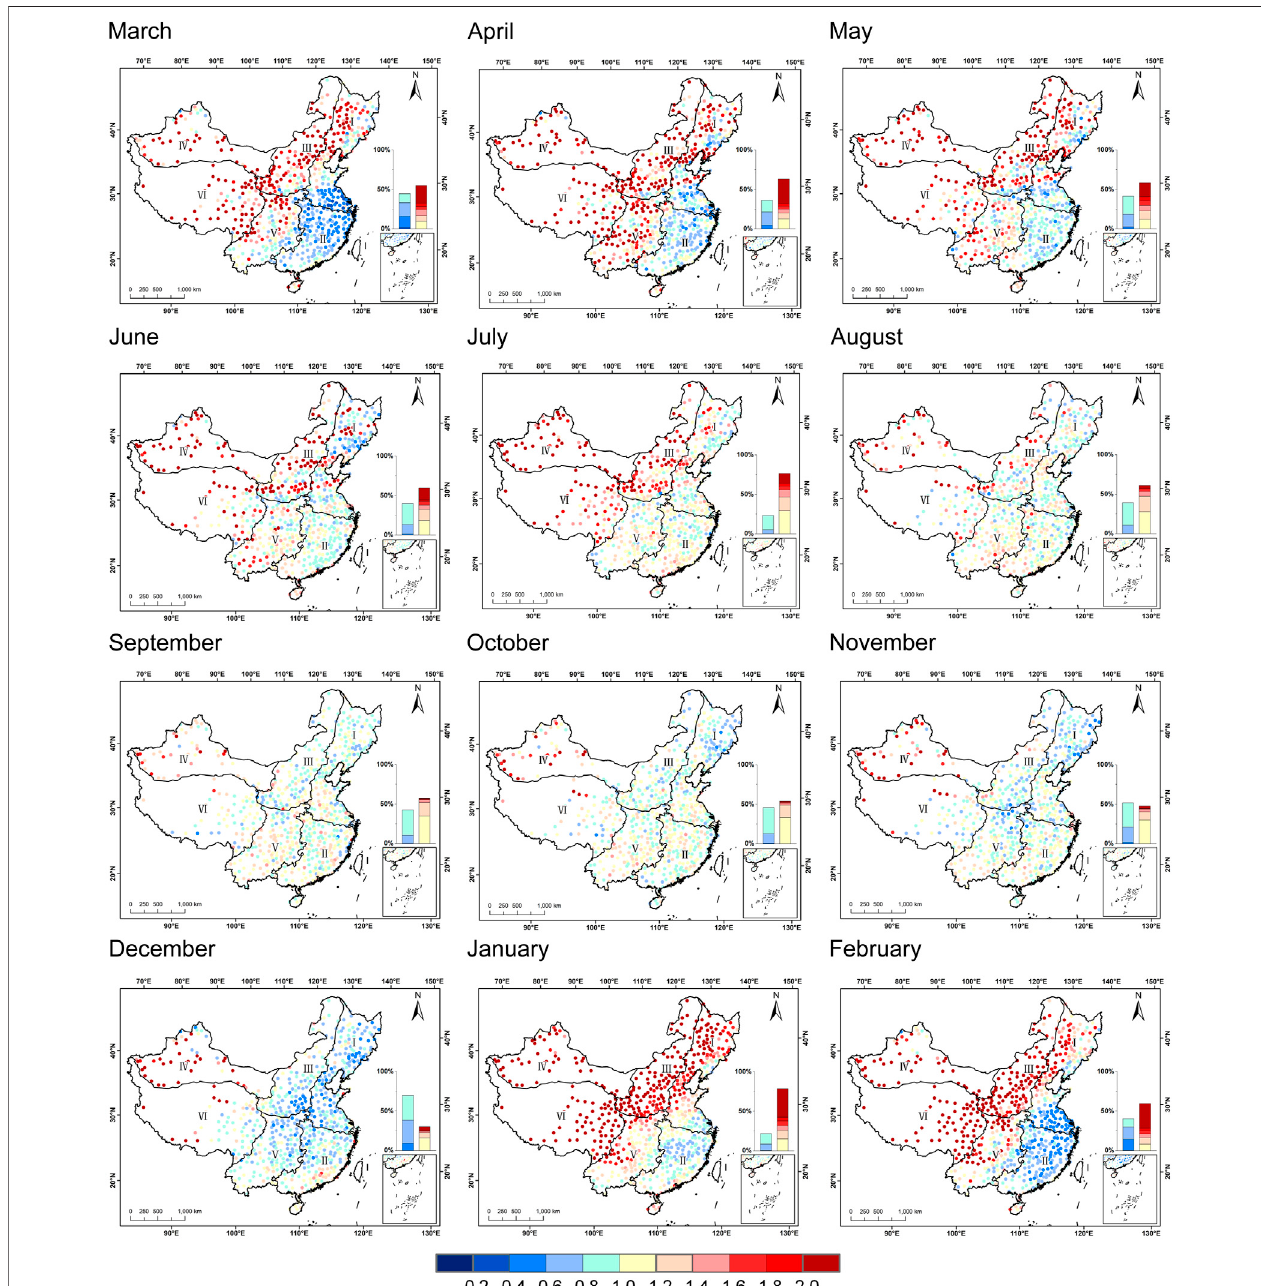
FIGURE 6 | Spatial distribution of DISO for RX1day of ERA5 over China from spring to winter. spring (March, April, and May), summer (June, July, and August), autumn (September, October, and November), and winter (December, January, and February).